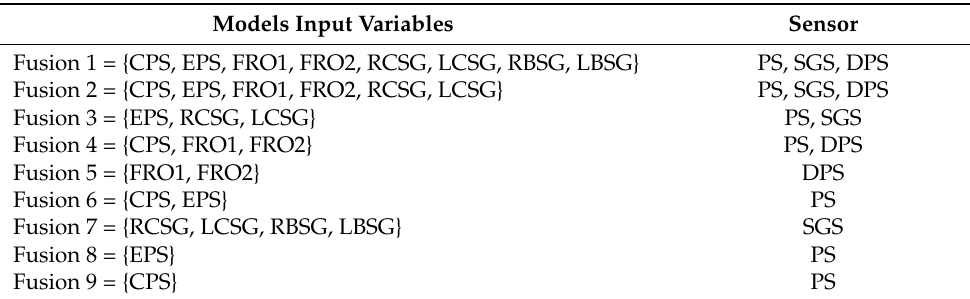
Table 2. Combinations between the different sensors tested in this